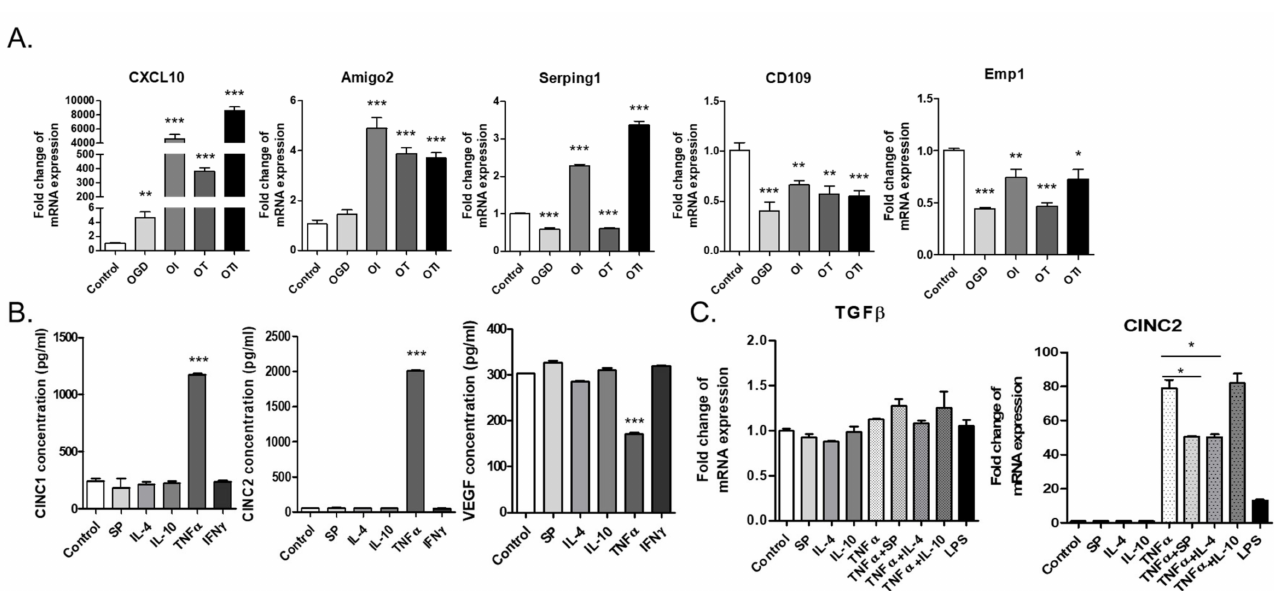
Figure 7. Phenotypic identity of reactive astrocytes in the mixed glial cell culture as A2 astrocytes: ( A ) quantitative analysis of AC d14 with CXCL10 (pan reactive astrocyte marker), Amigo2, Serping1 (A1 astrocyte markers), CD109, and Emp1 (A2 astrocyte markers) mRNA expression. ( n = 3) OGD: oxygen glucose deprivation; OI: IFN- γ treatment after OGD; OT: TNF- α treatment after OGD; OTI: TNF- α + IFN- γ treatment after OGD. ( B ) ELISA of CINC-1, CINC-2, and VEGF secreted by AC d14 cultured with various cytokines ( n = 3); ( C ) quantitative analysis of TGF- β and CINC-2 mRNA expression in AC d14 cultured with various cytokines ( n = 3). * p < 0.05, ** p < 0.01, and *** p <